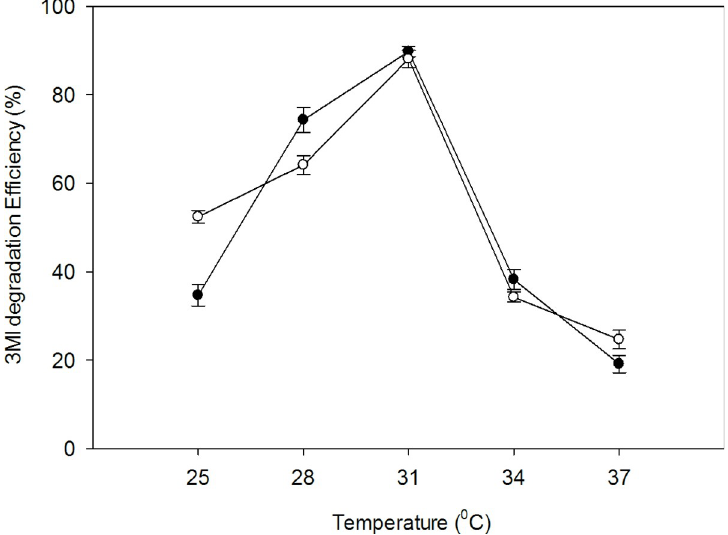
Fig 5. Effect of T (˚C) on 3MI degradation efficiency by the strains at pH 6, and 1mM 3MI concentration. Symbols: open circle, NTA1-2A strain; solid circle, TAT1-6A strain.